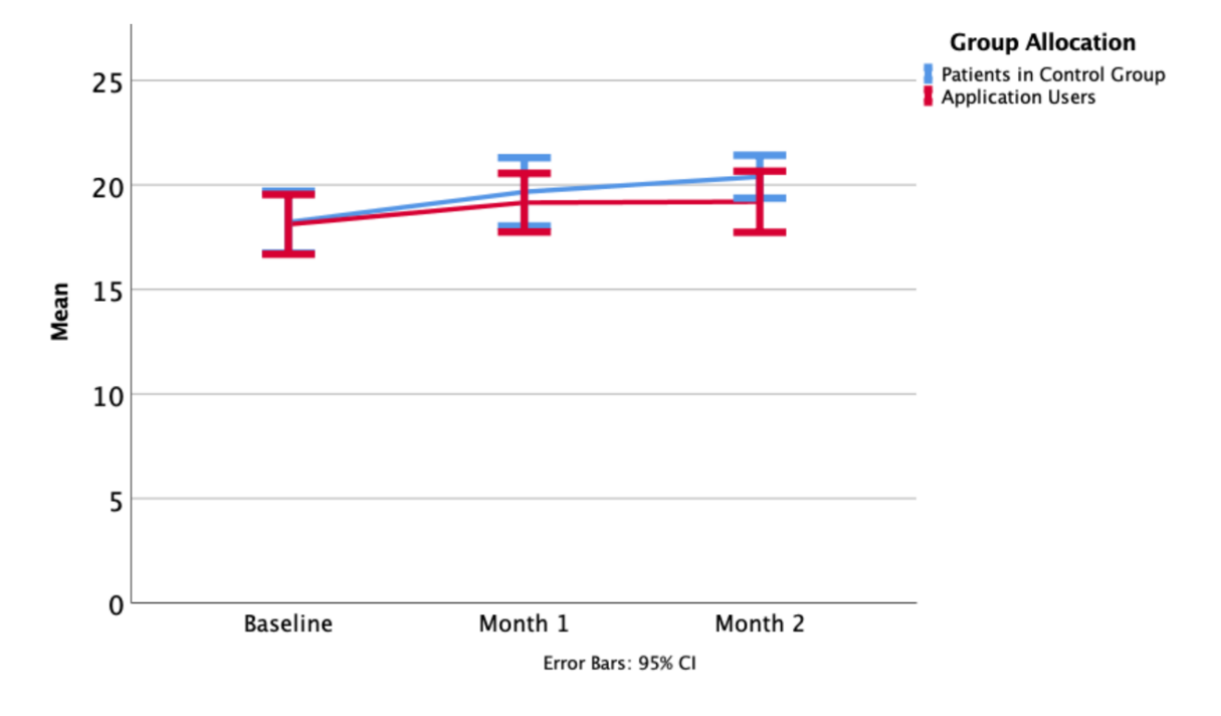
Figure 6. General version of the Functional Assessment of Cancer Therapy (FACT-G) Emotional wellbeing subscore means at baseline, one month, and at the end of the study period.